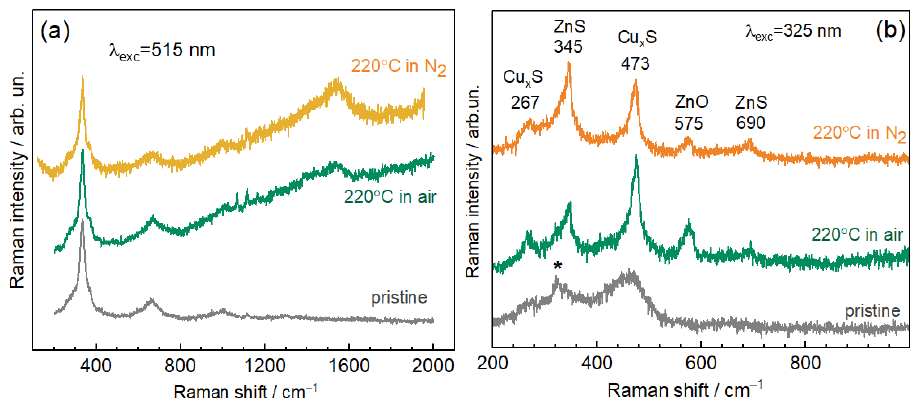
Figure 5. Raman spectra of the CZTS NC films with the nominal content Cu 2 measured with λ exc = 514.7 nm ( a ) and λ exc = 325 nm ( b ) on the pristine film and films annealed at 220 ◦ C in air and in N 2 . The feature marked by an asterisk in ( b ) is an artifact due to Raman scattering in the UV objective. The spectra at “green” excitation reveal amorphous carbon Raman bands and PL background after annealing in both air and N 2 conditions. The PL can be related to the